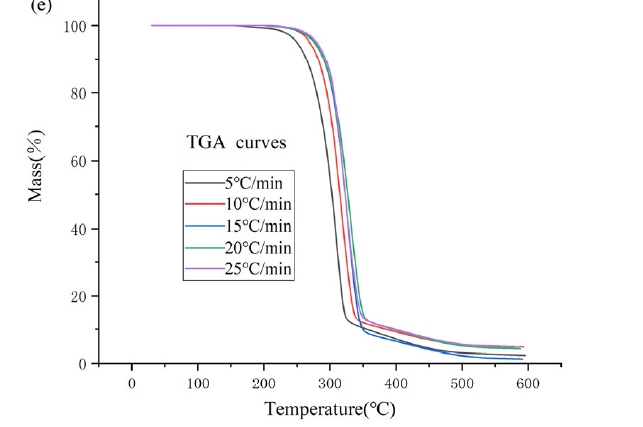
Figure 1. TGA curves of [Emmim][NO 3 ] ( a ), [Bmmim][NO 3 ] ( b ), [Hmmim][NO 3 ] ( c ), [Ommim][NO 3 ] ( d ) and [Dmmim][NO 3 ] ( e ) with different heating